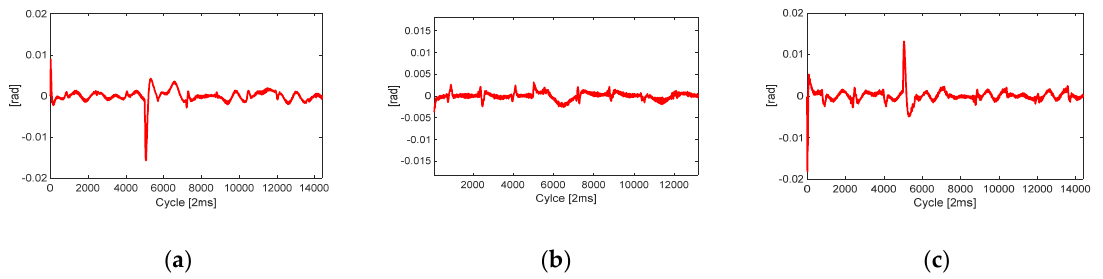
Figure 15. The synchronization error with multiple faults. ( a ) Joint 1; ( b ) Joint 2; ( c ) Joint 3.